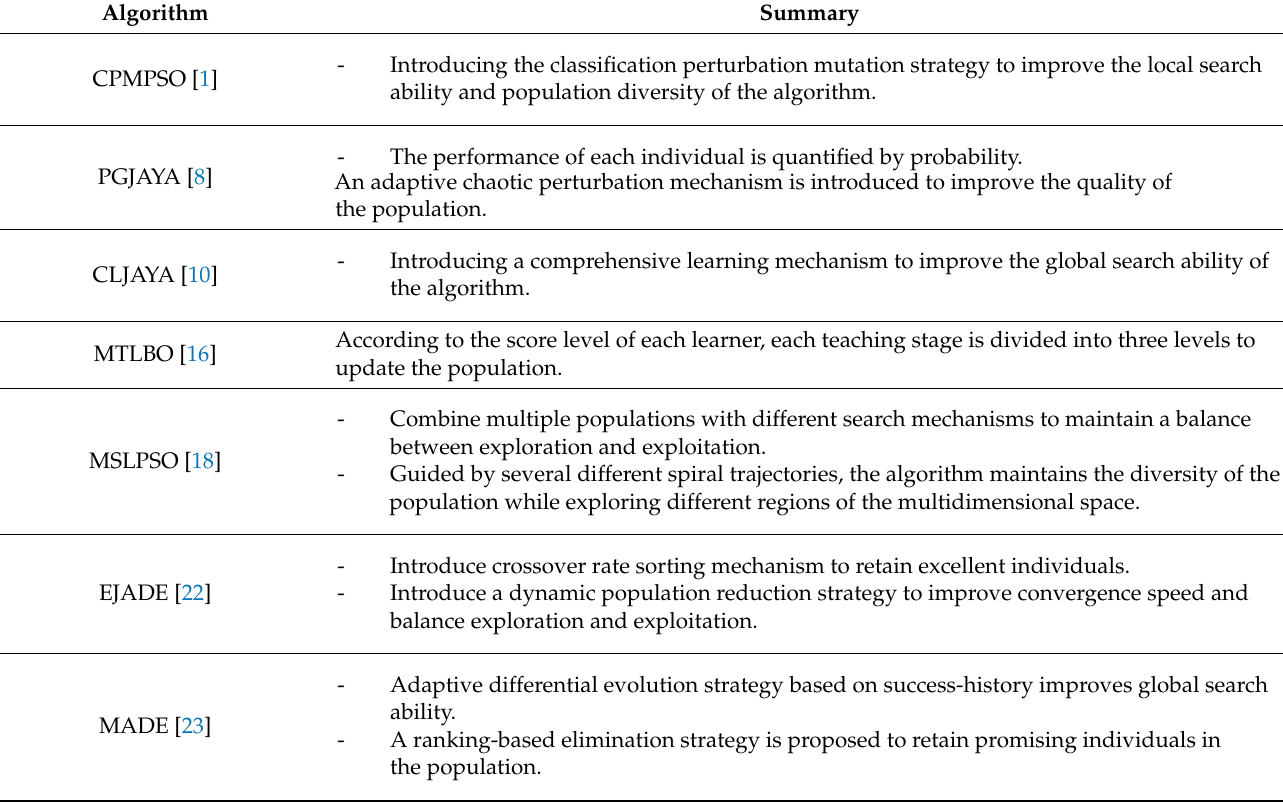
Table 2. Summary of some existing heuristic